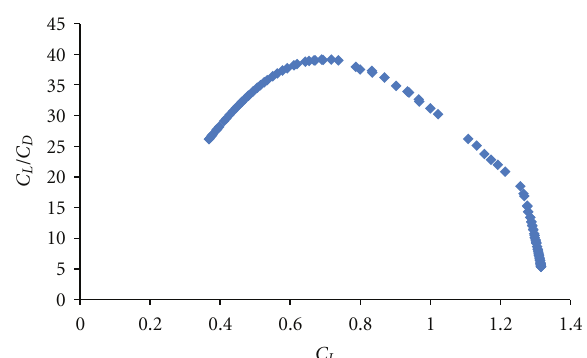
Figure 12: 2D presentation of non-dominated solutions of C L /C D versus C L .